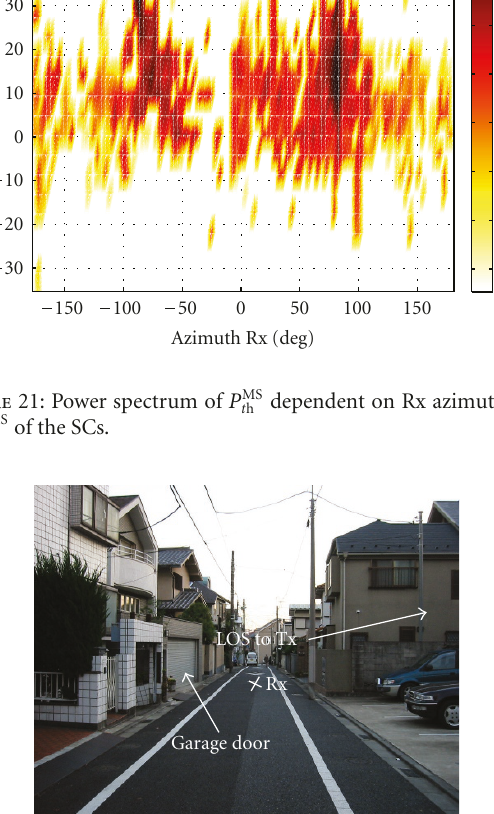
Figure 17: Normalized power distribution of P MS of the SCs, macrocell Rx19 to Rx27. XPR MS h